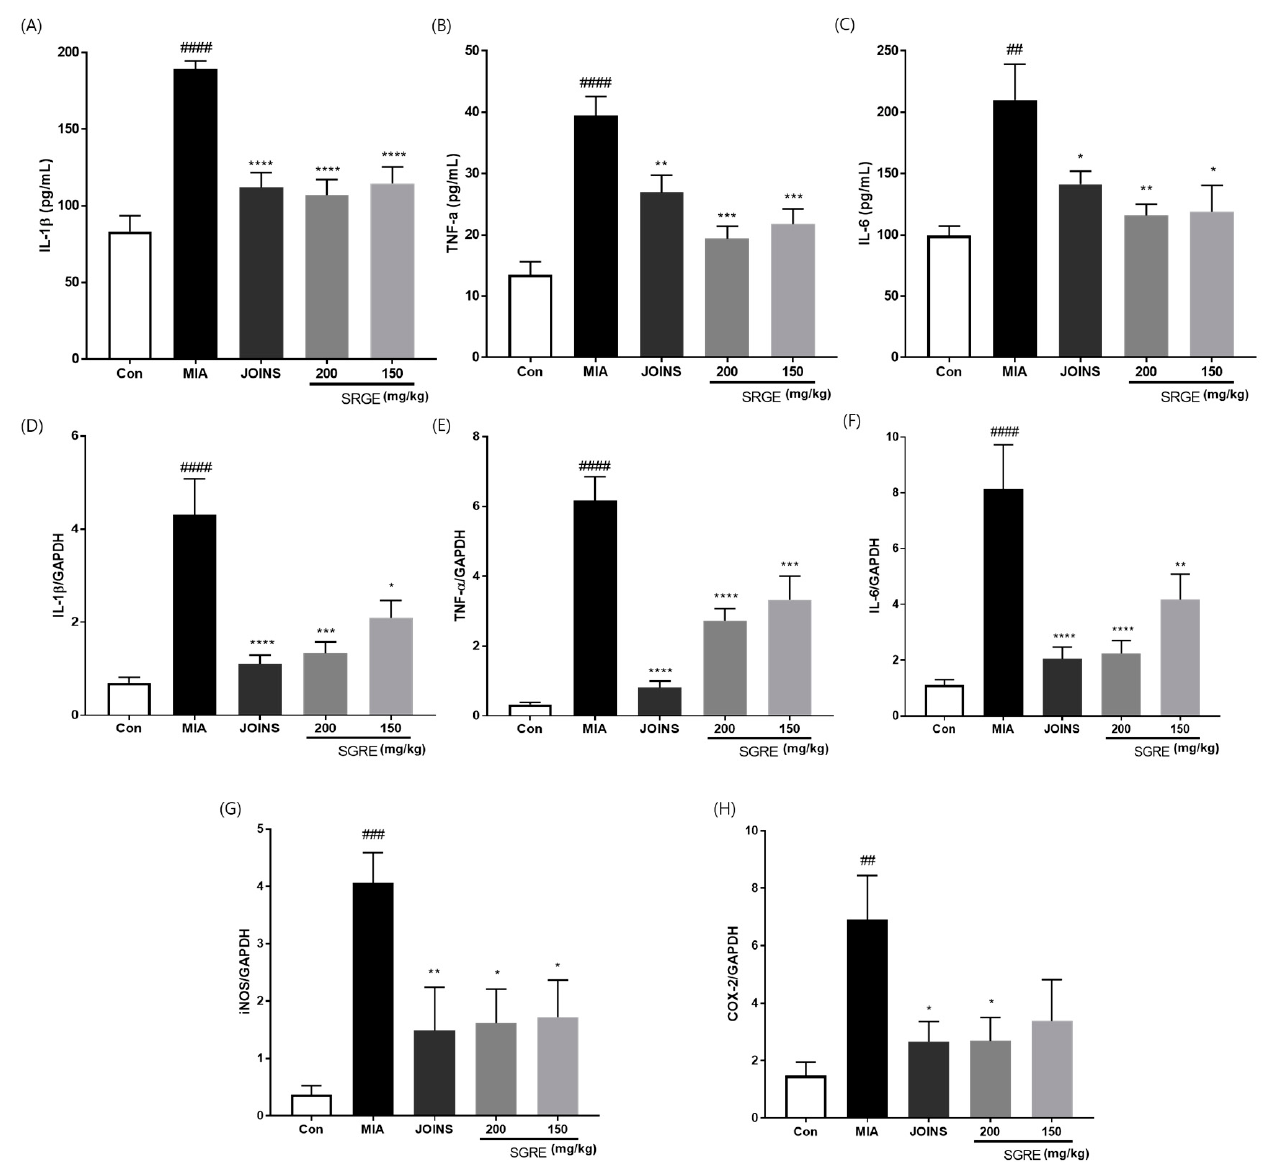
Figure 7. Effects of SGRE on the expression levels of inflammatory cytokines and enzymes in the MIA-induced group. The serum concentrations of ( A ) IL-1 β , ( B ) TNF- α , and ( C ) IL-6. The mRNA levels of ( D ) IL-1 β , ( E ) TNF- α , ( F ) IL-6, ( G ) iNOS, and ( H ) COX-2 in the joint articular cartilage tissue. n = 7 per group. ## p < 0.01; ### p < 0.001; #### p < 0.0001 vs. control group. * p < 0.05; ** p < 0.01; *** p < 0.001; **** p < 0.0001 vs. MIA-induced group.